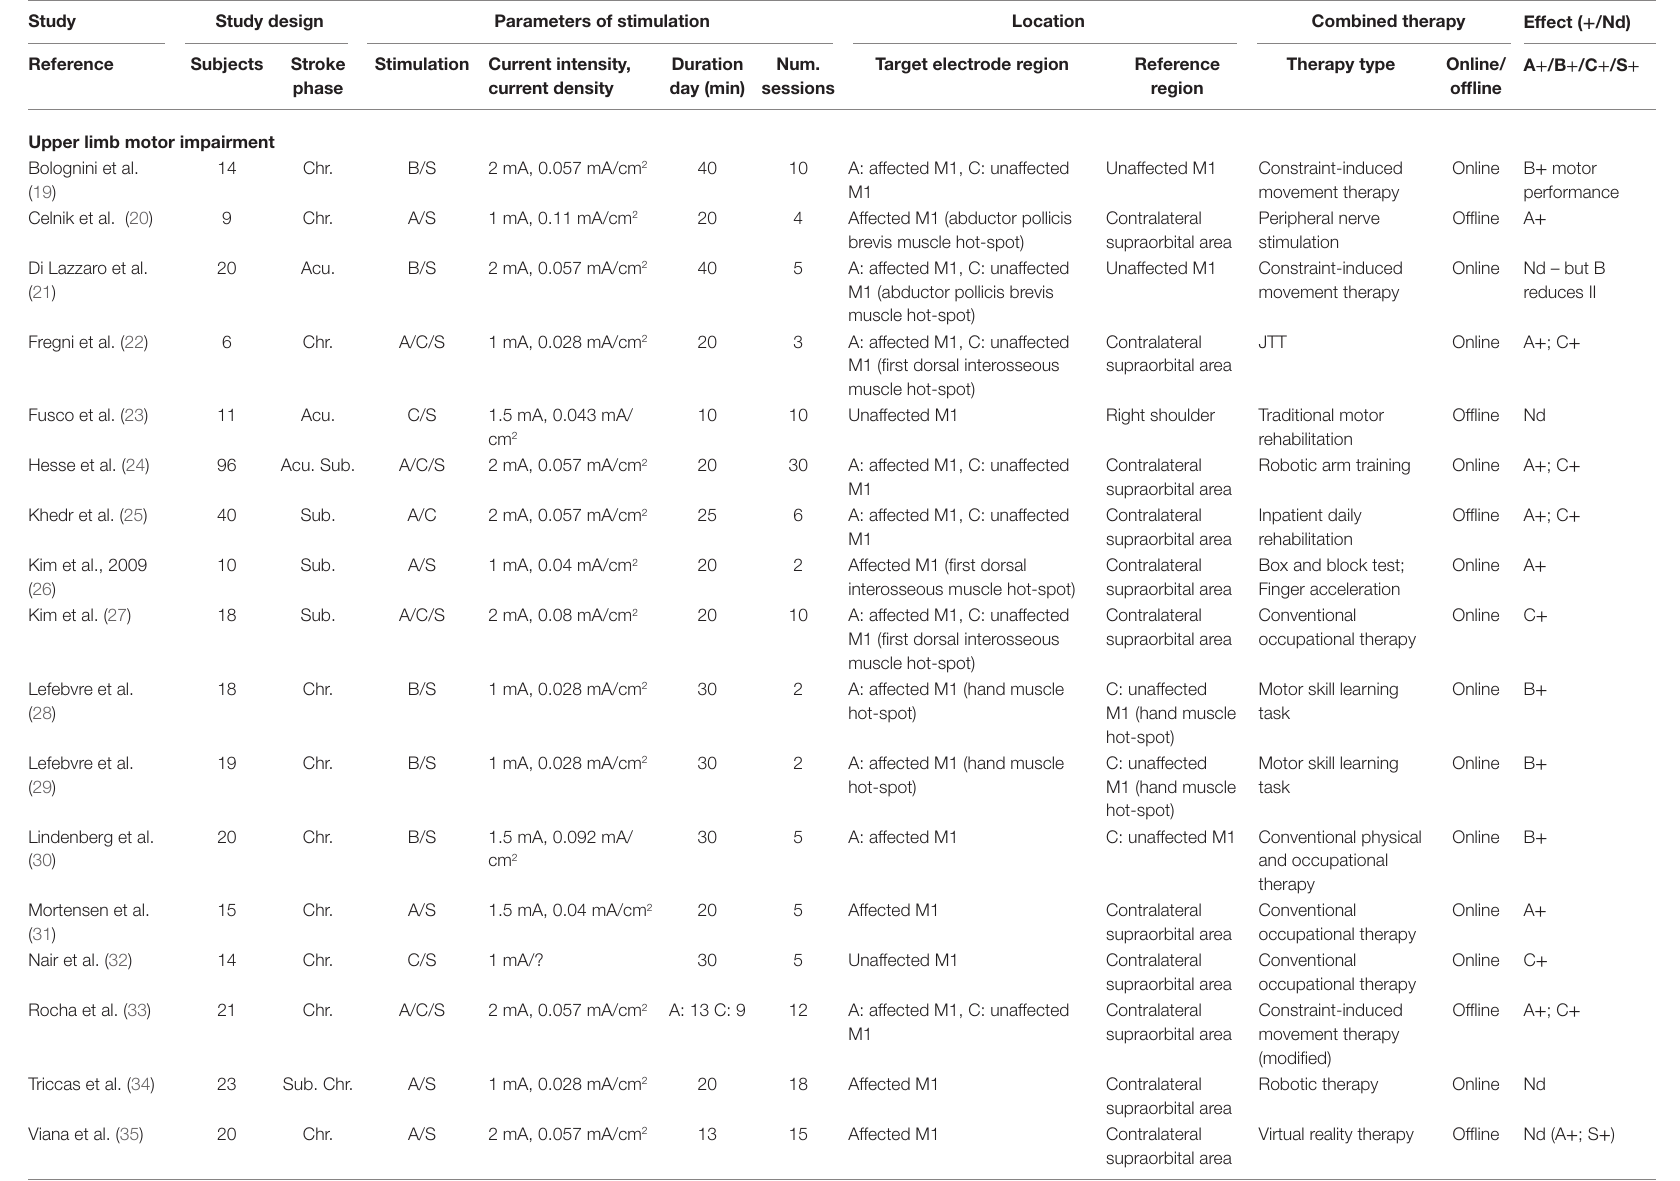
tABLe 1 | summary of tDcs-based poststroke neurorehabilitation